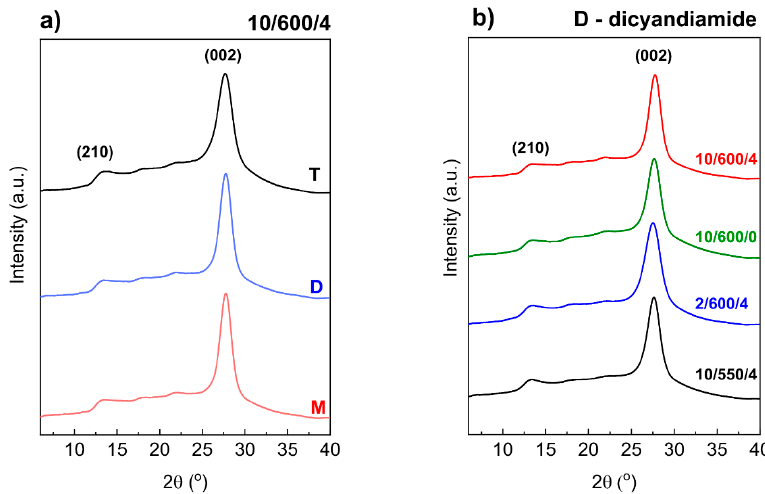
Figure 4. Influence of precursor on diffraction patterns of carbon nitrides obtained from various precursors under conditions of 10/600/4 ( a ) and influence of condensation conditions on diffraction patterns of carbon nitrides obtained from dicyandiamide ( b ).